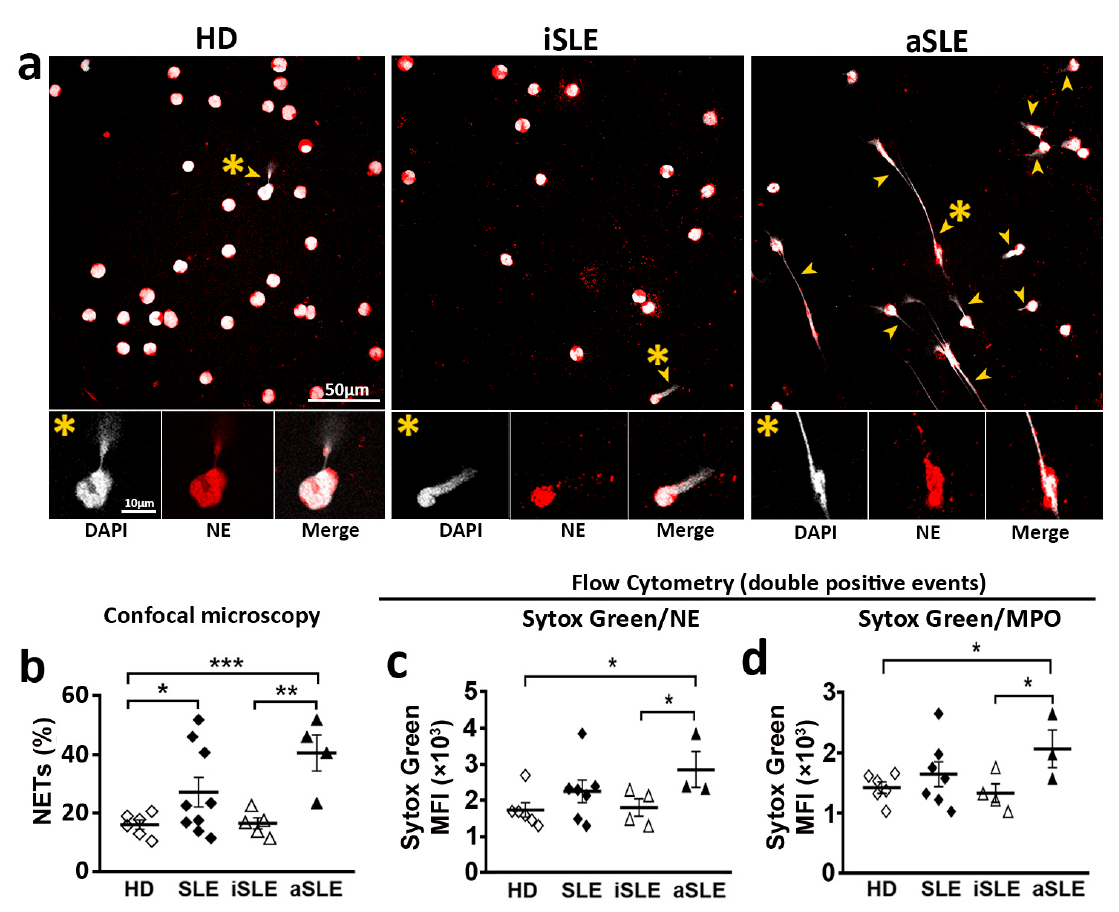
Figure 3. Susceptibility to NET generation of neutrophils from SLE patients and healthy donors in basal experimental conditions. Quantification of NETs generated by neutrophils from HD, iSLE patients and aSLE patients. ( a ) Representative fields of DAPI/NE stained unstimulated neutrophils from HD, iSLE and aSLE obtained by confocal microscopy with a 63x objective. Scale bar = 10–50 µ m. Yellow arrowheads indicate NETs. Yellow asterisks indicate NETosing cells amplified below the image. ( b ) Percentage of NETs quantified by confocal microscopy. ( c , d ) MFI of Sytox Green in ( c ) Sytox Green/NE-APC and ( d ) Sytox Green/MPO-PE double positive events, respectively. Statistical analysis was performed using unpaired Student’s t -test and Mann-Whitney test. * p ≤ 0.05; ** p ≤ 0.01, *** p ≤ 0.001. Data show mean fluorescence intensity (MFI) ± SEM or percentage ± SEM. HD ( n = 6–12), iSLE ( n = 4–7), aSLE ( n = 3–8). HD: healthy donors. SLE: Systemic Lupus Erythematosus. iSLE: inactive SLE. aSLE: active SLE. NETs: Neutrophil extracellular traps. NE: Neutrophil Elastase. MPO: Myeloperoxidase. SLE = Total population of patients included.